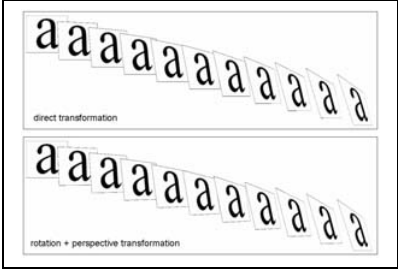
Figure 7. Direct transformation method and the present method produce the same intermediate images while there is little rotation presence between the two ends of status.